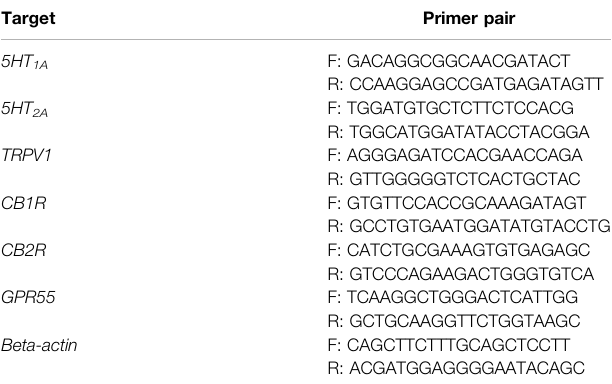
TABLE 1 | Primers used for qRT-PCR analyses of target CBD receptors.